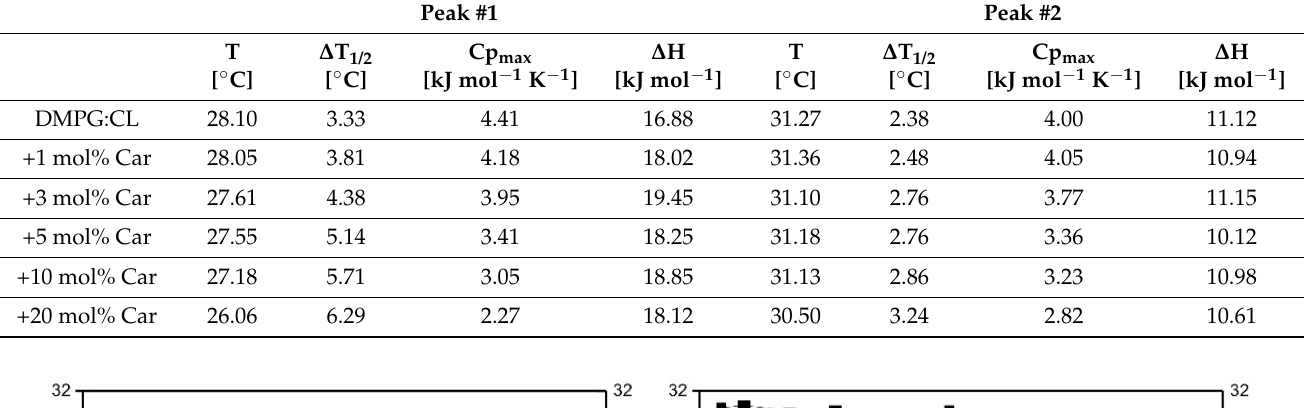
Table 1. Phase-transition temperatures (T m ), full-width at half-maximum (ΔT 1/2 ), and peak height (Cp max ) of deconvoluted peaks from representative DSC heating curves obtained for multilamellar liposomes prepared from DMPG and CL mixture (DMPG:CL, 80:20).